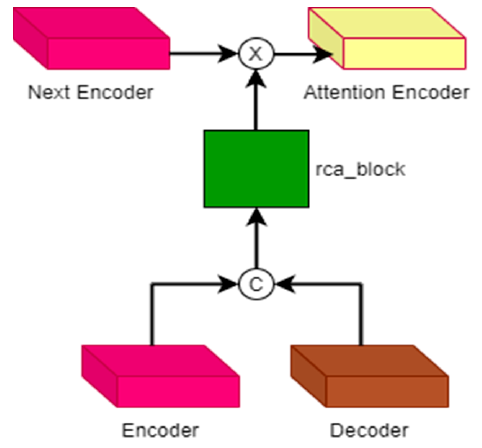
Figure 5. Architecture of proposed CSFF block.